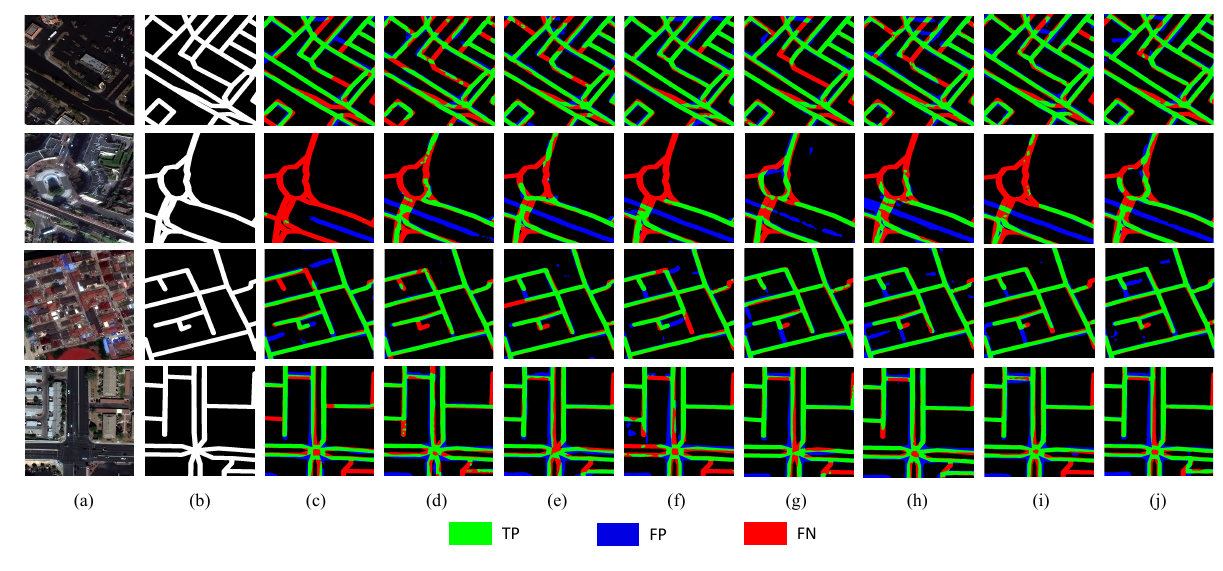
Figure 11. Results of road extraction on the SpaceNet dataset. ( a ) RGB satellite imagery. ( b ) Ground truth. ( c ) LinkNet. ( d ) D-LinkNet. ( e ) HRNet. ( f ) CCNet. ( g ) DANet. ( h ) DBRANet. ( i ) NL-LinkNet. ( j ) MSFANet.